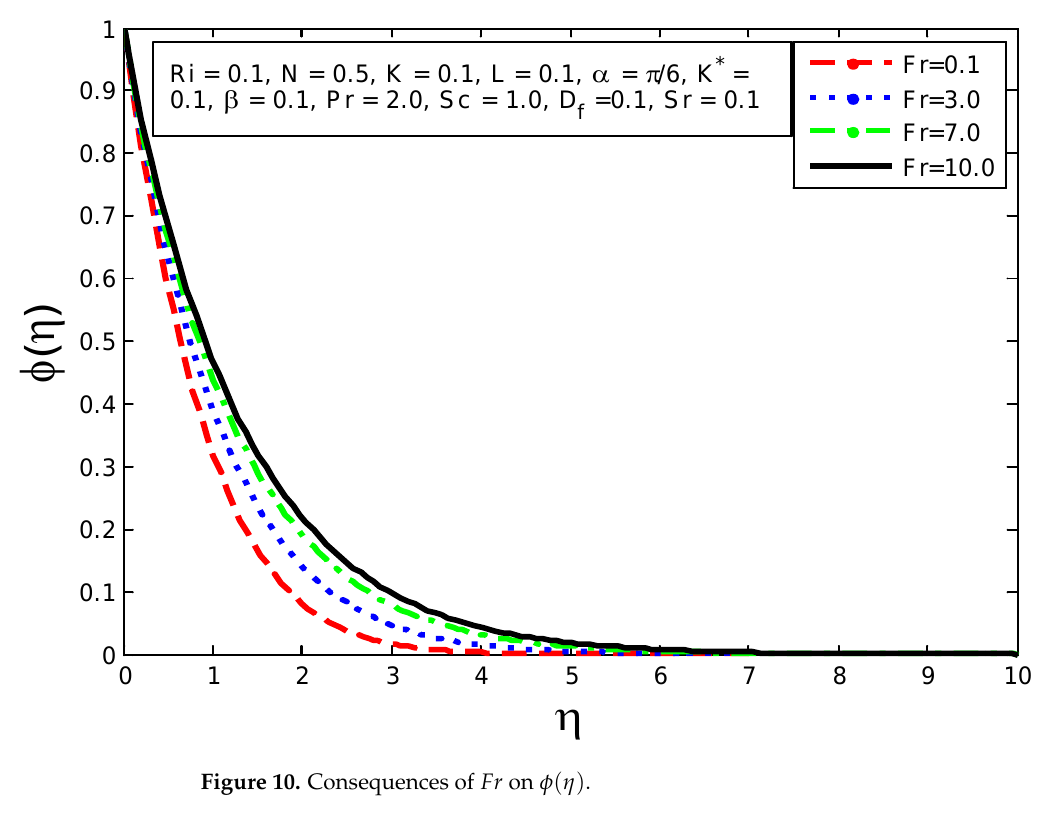
Figure 9. Consequences of